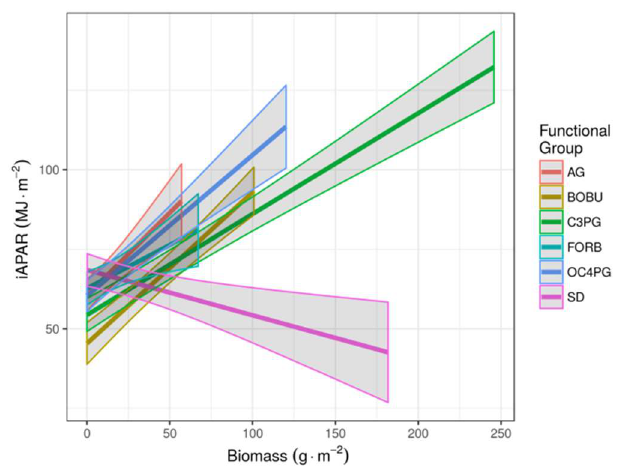
Figure 7. Visualization of the CARM model coefficients from Table 2.